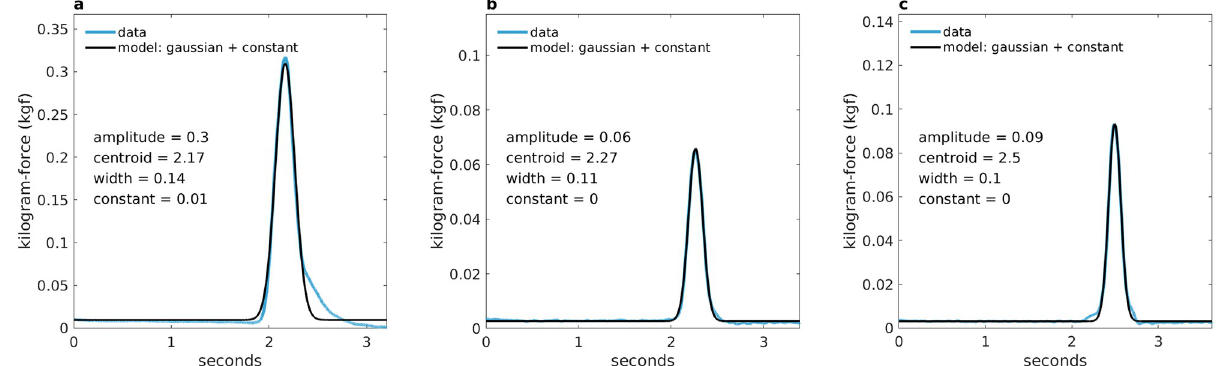
Fig 3. Grip response and grip response model of three trials from a single participant. The grip responses were modelled with a Gaussian function with parameters for amplitude, centroid, width, and a constant. A: trial 14, b: trial 152, c: trial 180. R -squared = 0.983, 0.998 and 0.997, respectively. Blue: preprocessed (baseline-corrected, normalised to maximal voluntary contraction [MVC], and smoothed) grip response data, black: modelled grip response. The unit of the x-axis and centroid parameter has been converted to seconds (sampling frequency: 2000 Hz, 1 s = 2000 samples).